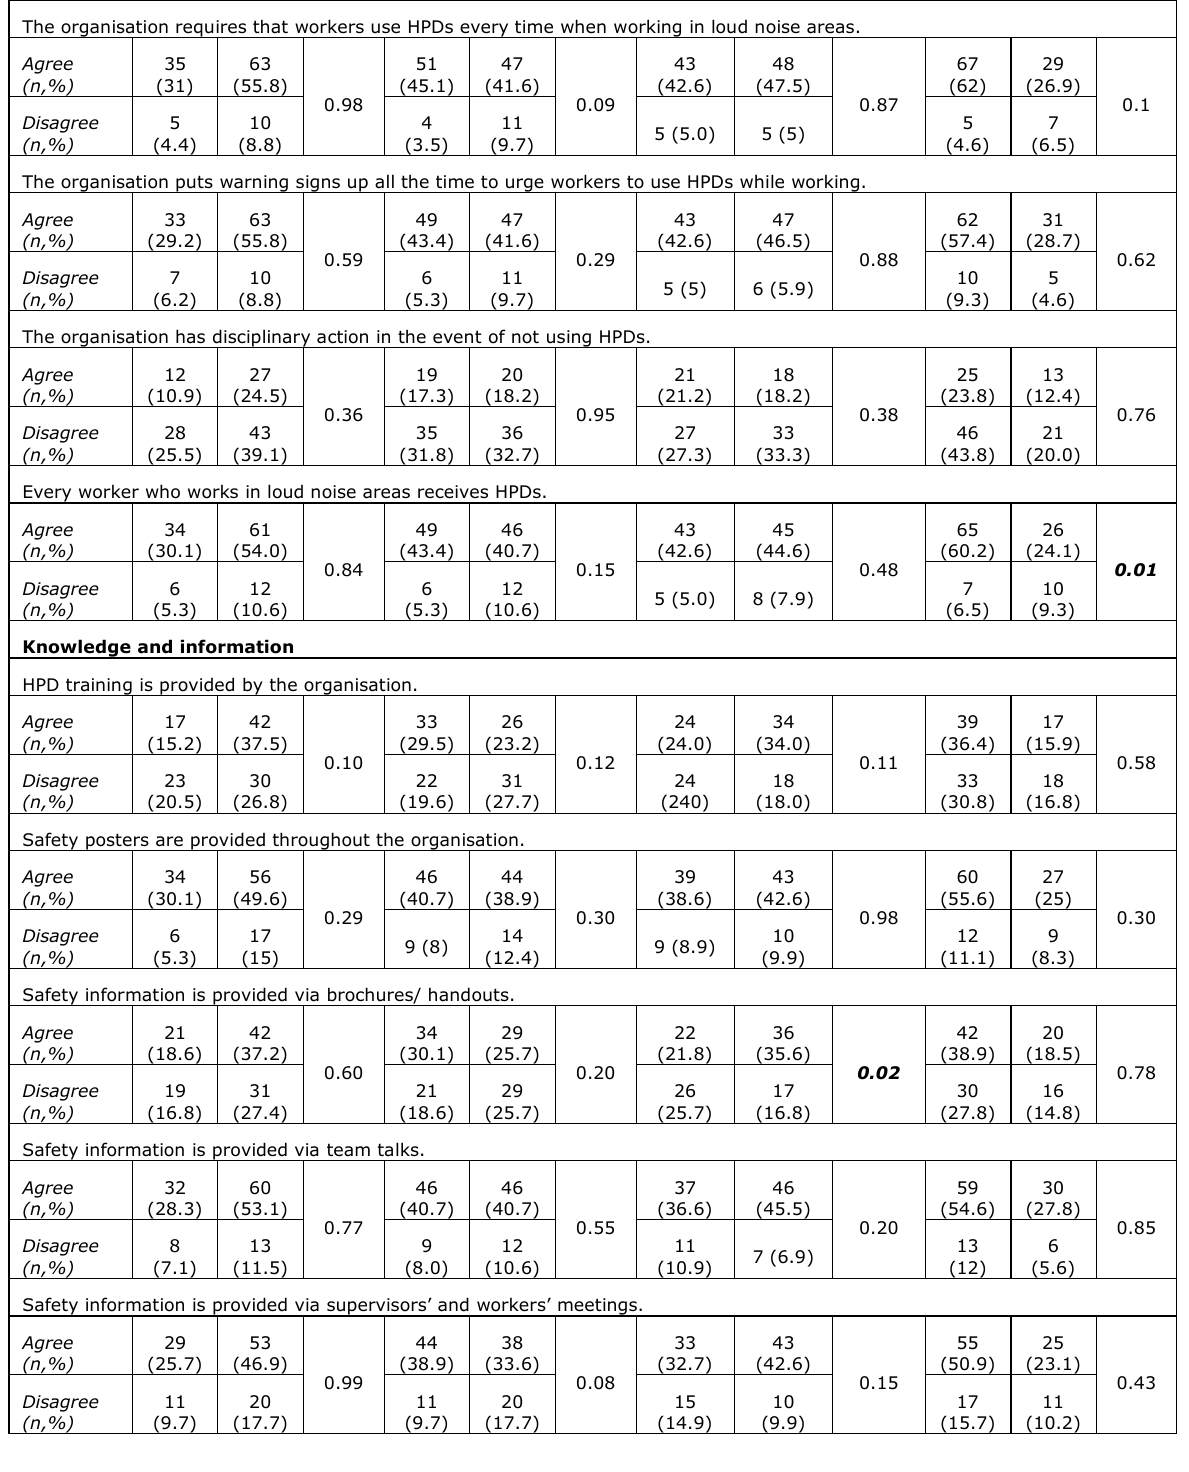
Hours per day wearing HPDs p- p- ≤ 6 > 6 value